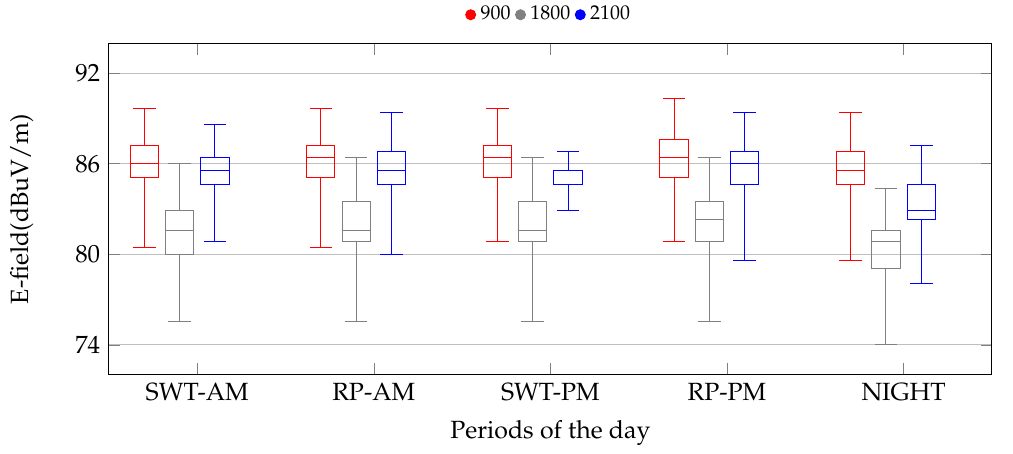
Figure 11. Distribution of the E-field for different frequency bands and during different periods of time. The results are grouped for the different times of the day (standard working time and resting periods), and the values for the different frequency bands are indicated in each